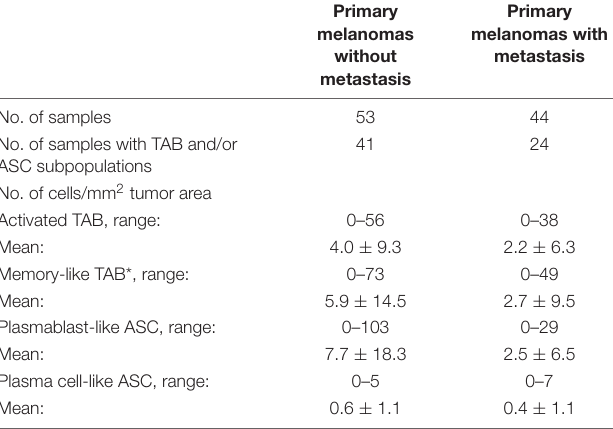
TABLE 3 | Summary of multiplex immunohistochemistry staining results in primary melanoma samples.